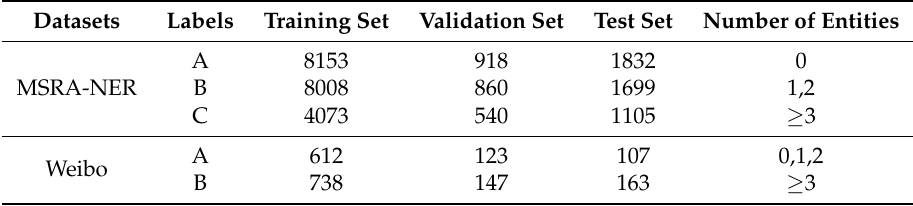
Table 3. The summary of